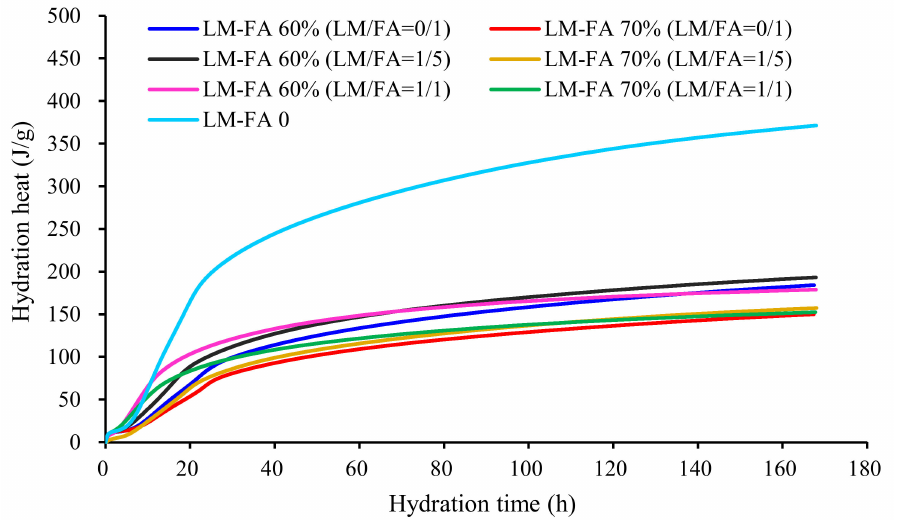
Figure 13. Influence of LM and FA on hydration heat of